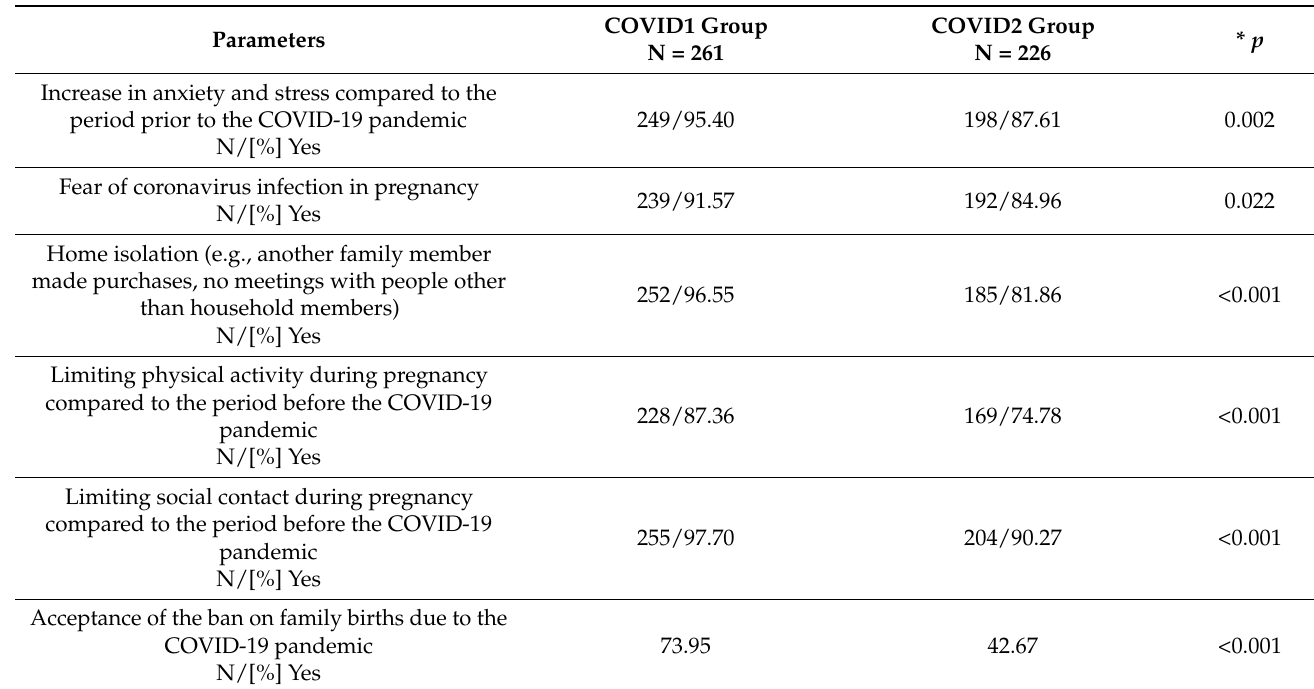
Table A3. Changes in the psychophysical state and lifestyle of pregnant women due to the pandemic and related